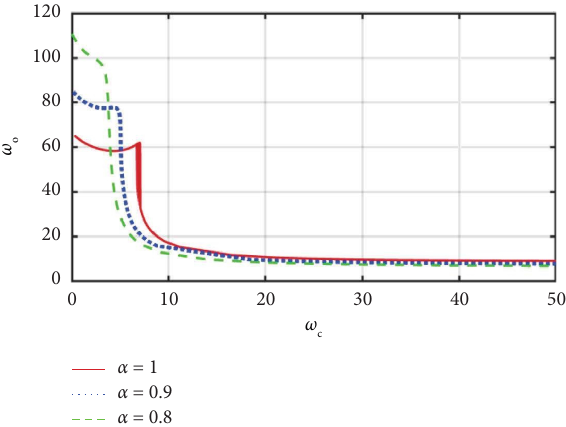
Figure 14: Te stability region of the antenna ( ω